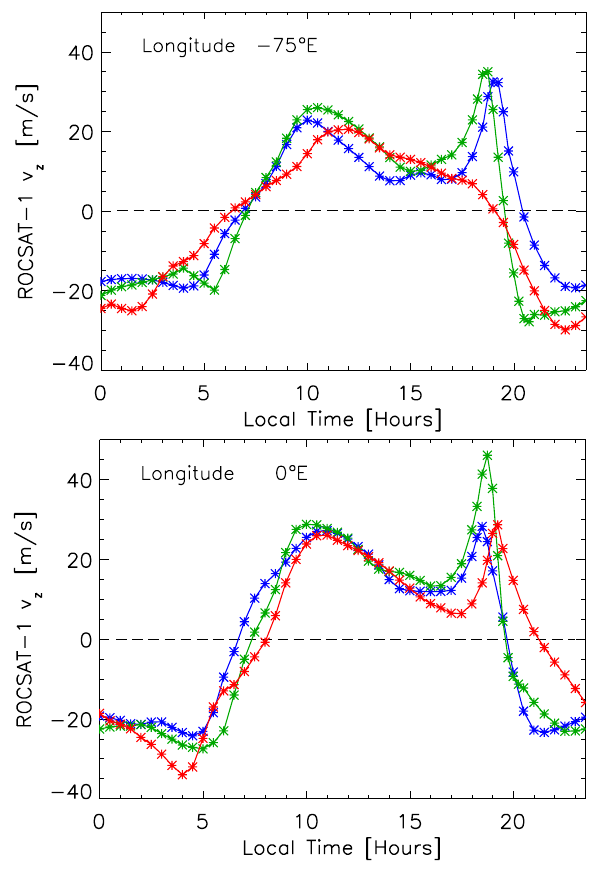
Fig. 1. Local time variation of the equatorial vertical plasma drift at two longitudes, as predicted by the ROCSAT-1 plasma drift model for December solstice (blue), equinox (green), and June solstice (red) for a solar flux level of F10.7 = 150.